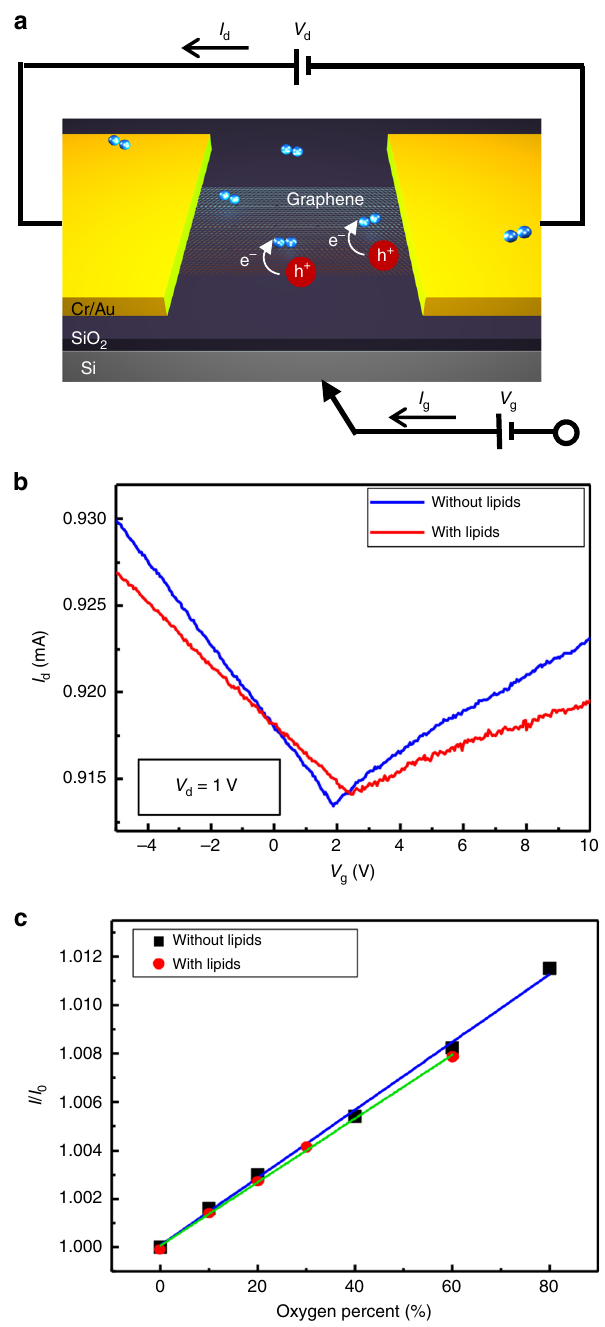
Fig. 2 Electric characteristics of graphene FET sensors. a Schematic image describing how the FET-based sensor detects the oxygen gas using graphene. Black arrows represent the direction of drain current ( I b Transfer characteristics of graphene FET. Drain voltage ( V gate voltage ( V ) is swiped from − 5 to 10 V. Blue and red curve indicate g I – V d g curves of the FET sensor without and with lipid c Sensing response calibration graph of the oxygen gas sensor as function of oxygen percent from 0 to 80% with and without lipids. Dots represent the real response data. Blue and green lines are linear fi ts of with and without lipids, respectively (correlation coef fi cient ( R 2 ) =